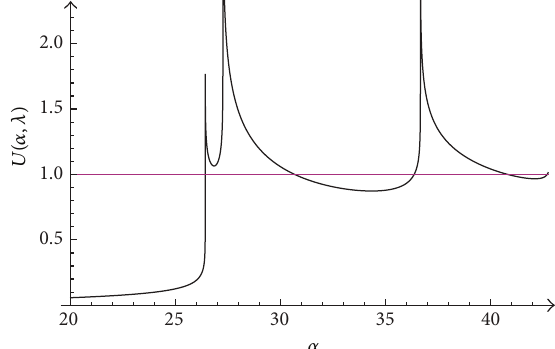
Figure 16: Six solutions of problem (15), (10), 𝛼 ≈ 28.0128 , 𝛼 ≈ 28.4601 , 𝛼 ≈ 31.8026 , 𝛼 ≈ 38.7197 , 𝛼 ≈ 42.1239 , and 𝛼 ≈ 45.4026 .